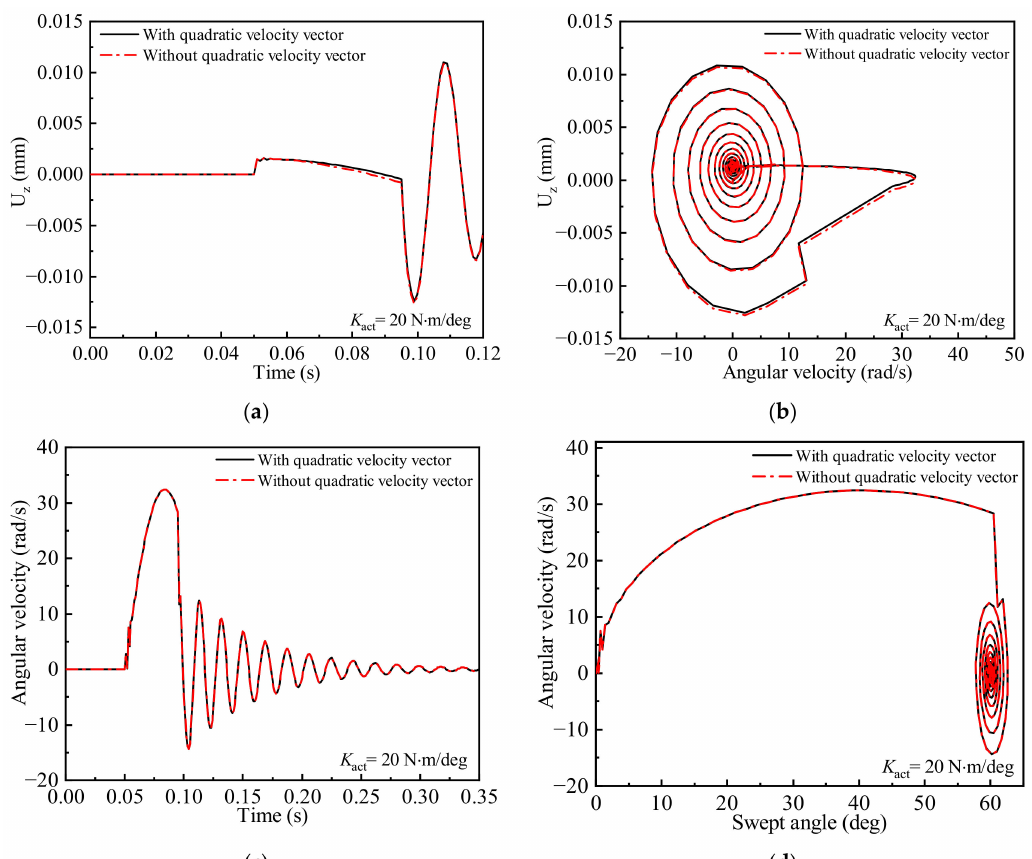
Figure 25. Effect of the quadratic velocity term on the displacement responses, K act = 20 N · m/deg. ( a ) Z-displacement vs. time. ( b ) Z-displacement vs. angular velocity. ( c ) Angular velocity vs. time. ( d ) Angular velocity vs. sweep